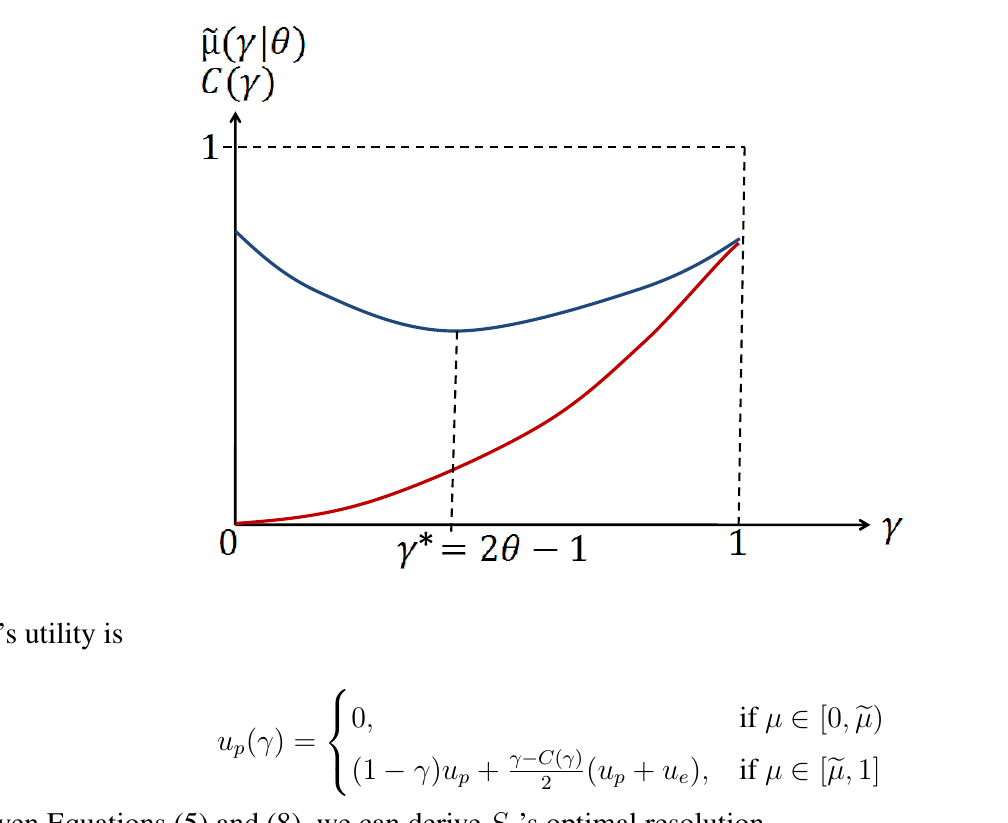
Figure 1. Critical inhibition